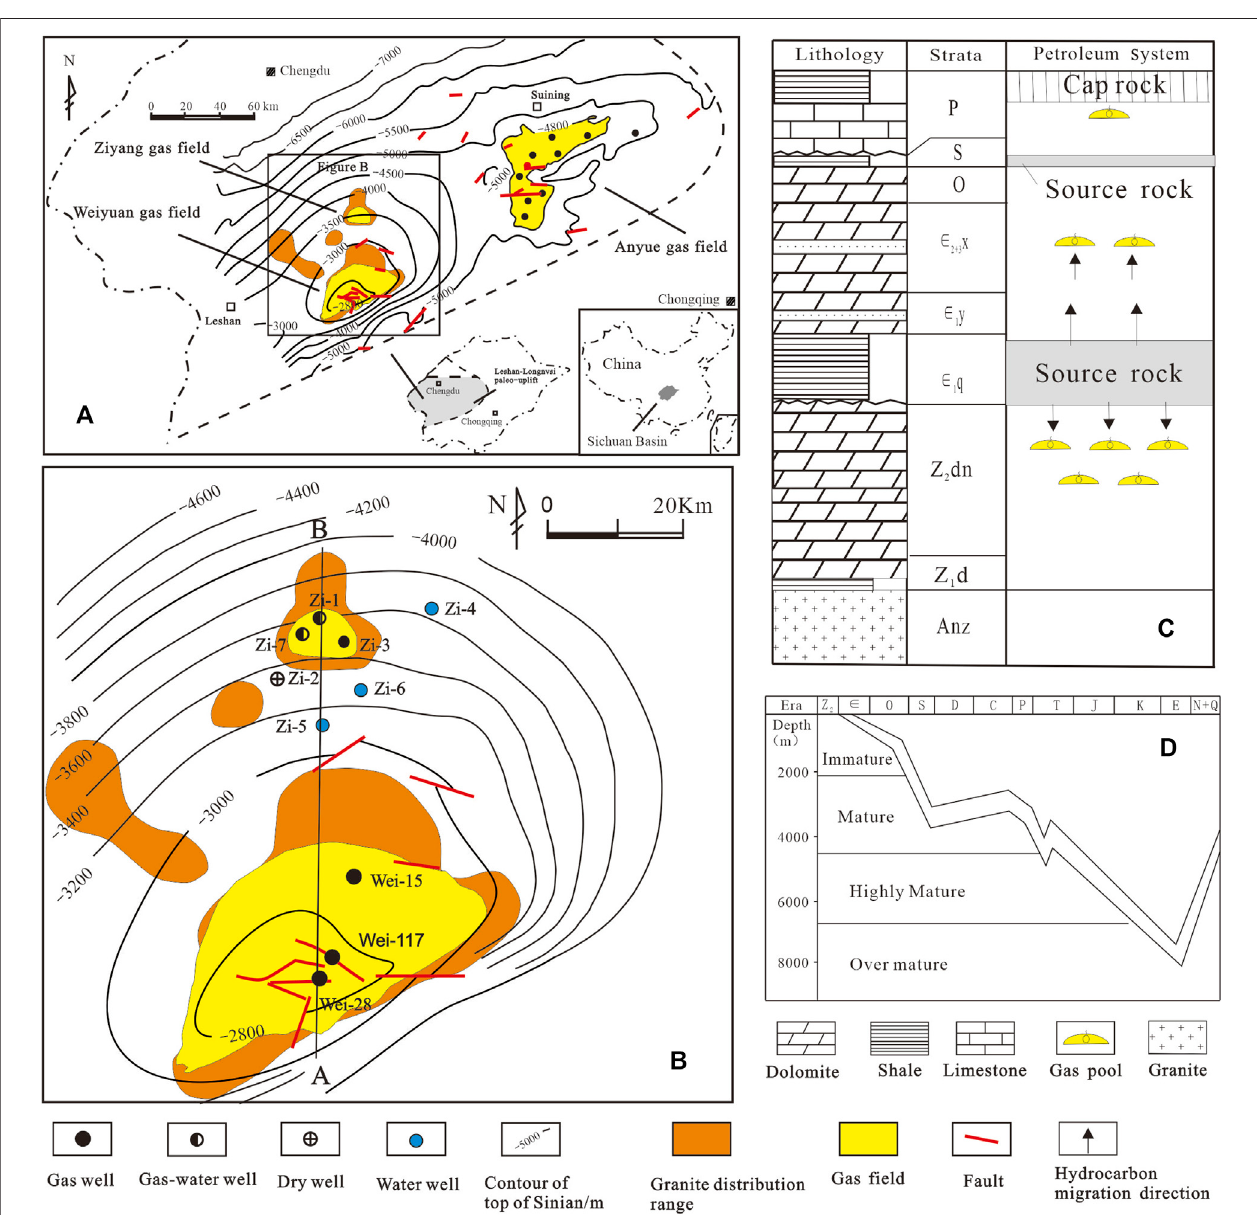
FIGURE6| Gas fi eldandgranitedistribution mapofLeshan-Longnüsipaleo-upliftinSichuanBasin,China(ThelocationofWeiyuangas fi eldisshown in Figure1 ). (A) Gas fi elds and granite distribution on Leshan-Longnüsi paleo-uplift. (B) More details of Weiyuan and Ziyan gas fi elds. (C) Petroleum system of Leshan-Longnüsi paleo-uplift. (D) Tectonic evolution of Leshan-Longnüsi paleo-uplift.